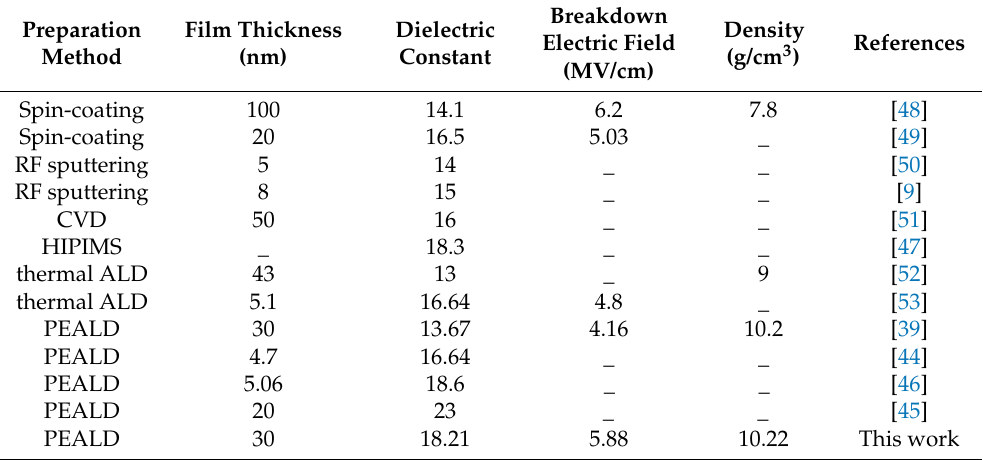
Table 2. The Comparison of important parameters under different preparation